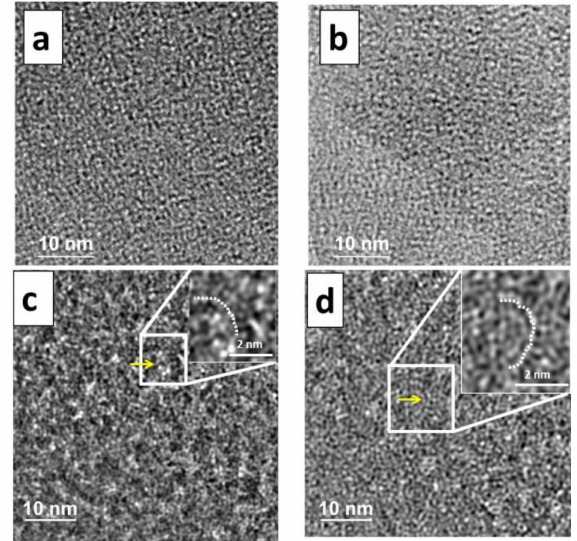
Figure 2. High-resolution electron microscopy images of the a-silica compounds S1 ( a ), S2 ( b ), S3 ( c ), and S4 ( d ). The area inside the white rectangle has been enlarged to show the ring structure. Enlarged images are inserted for S3 ( c ) and S4 ( d ), in which the nanopore ring formations are marked with white dots. Yellow arrows within the white square area indicate a nanopore ring